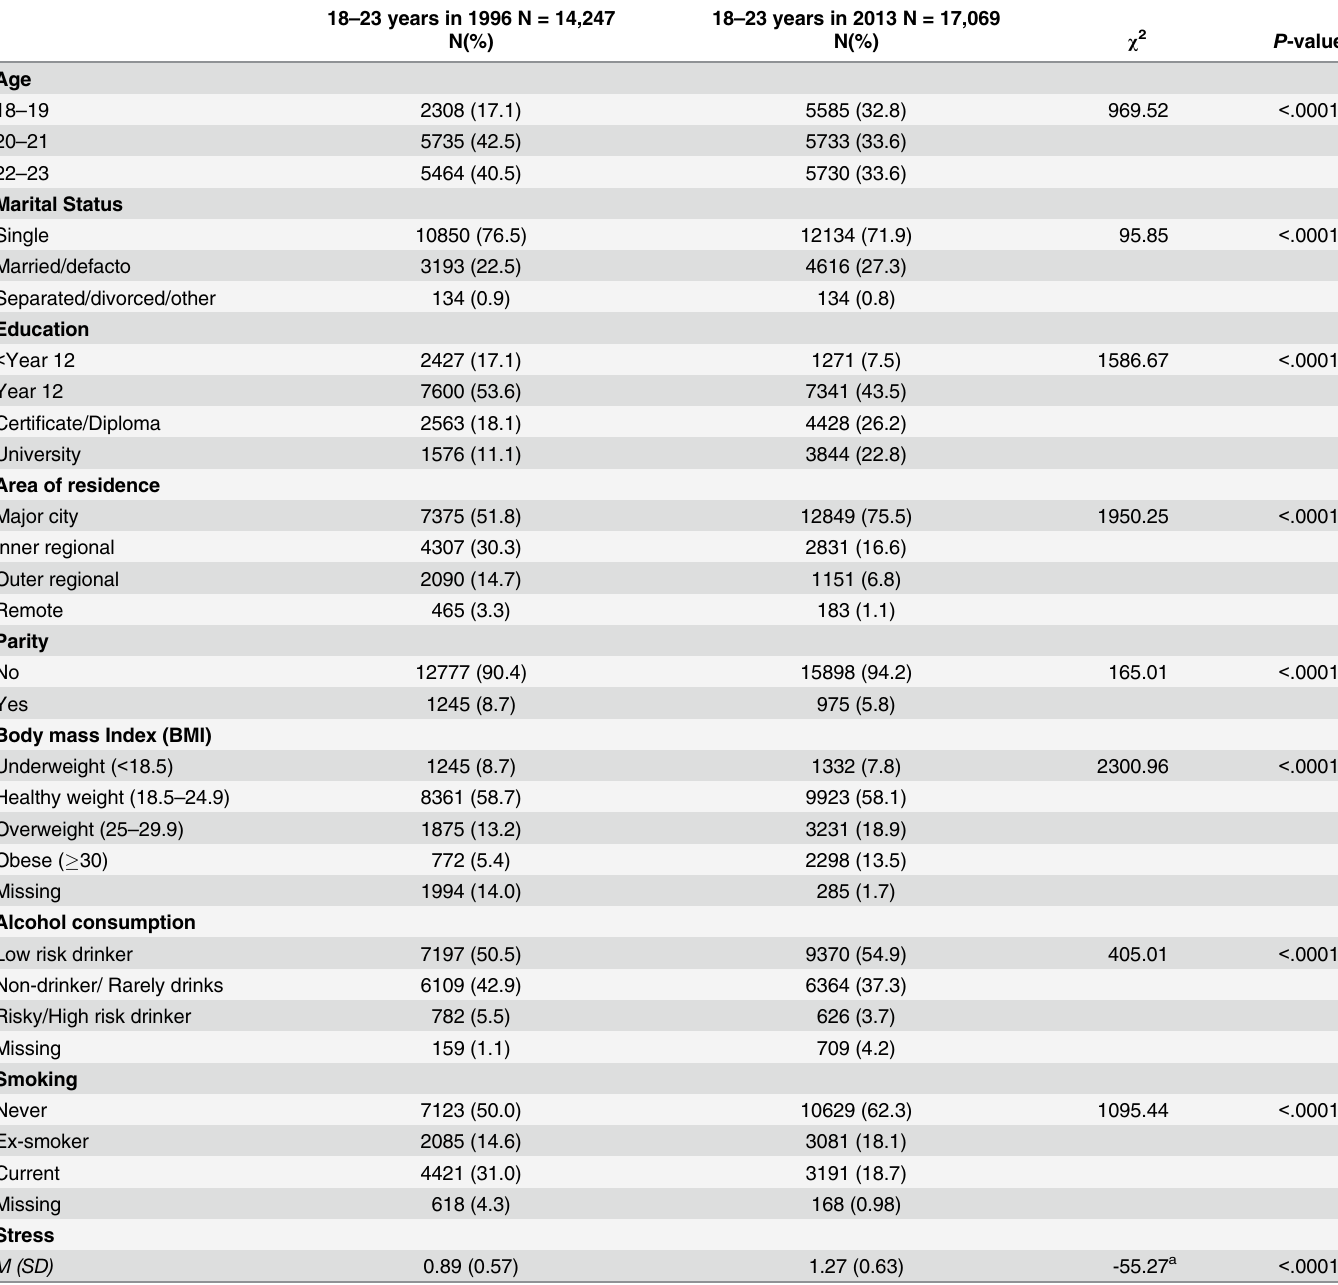
Table 1. Characteristics of two cohorts of young Australian women who were aged 18 – 23 years when first surveyed in 1996 and in